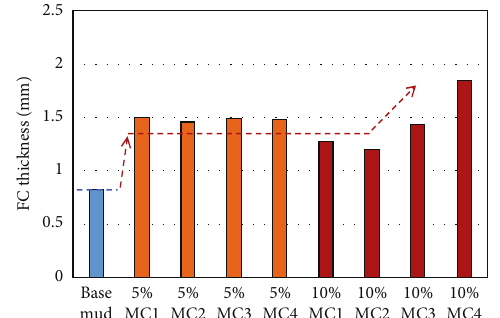
Figure 10: Filter cake thickness as function of adding di ff erent cuttings to the base mud.